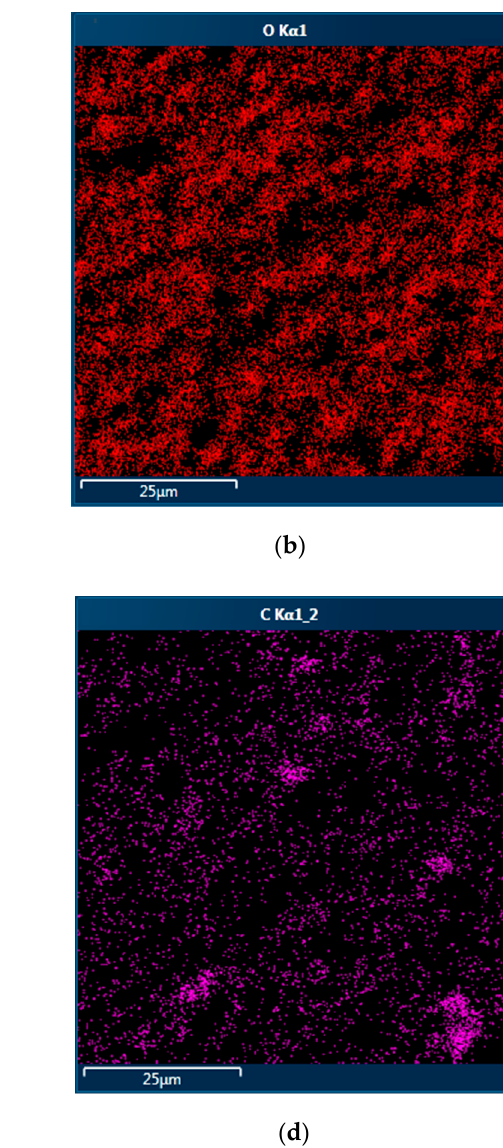
Figure 6. Topology of the Al 2 O 3 + 30%TiC nanocomposite machined surface: ( a ) oil, 10.0 k×; ( b ) water, 10.0 k×; ( c ) oil, 40.0 k×; ( d ) water, 40.0 k×.